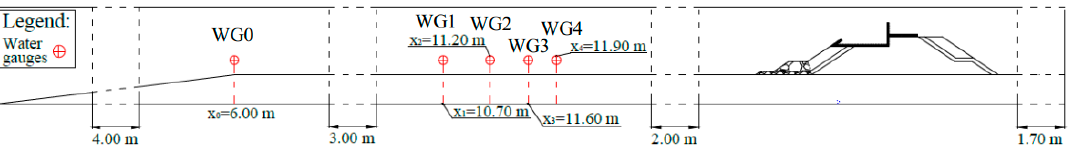
Figure 3. The positions of the wave gauges for the evaluation of K r .